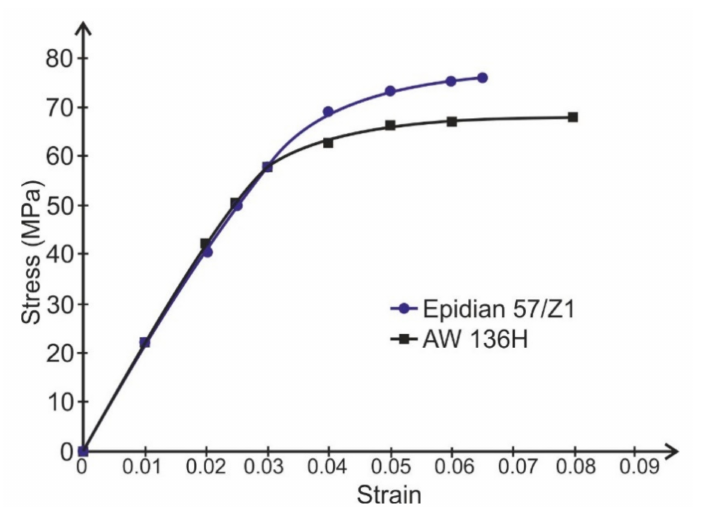
Figure 7. The stress–strain curves for Epidian 57/Z1 and AW 136H adhesive (compression curves without the considering of specimen cross-section area change).